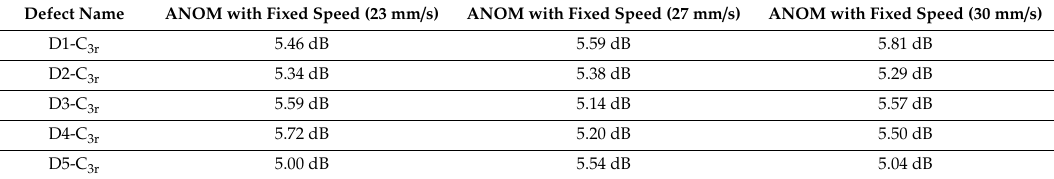
Table 5. ANOM results when Factor A is tested on the Quadrant 1 of the high-density sample (C100 \ Q1).